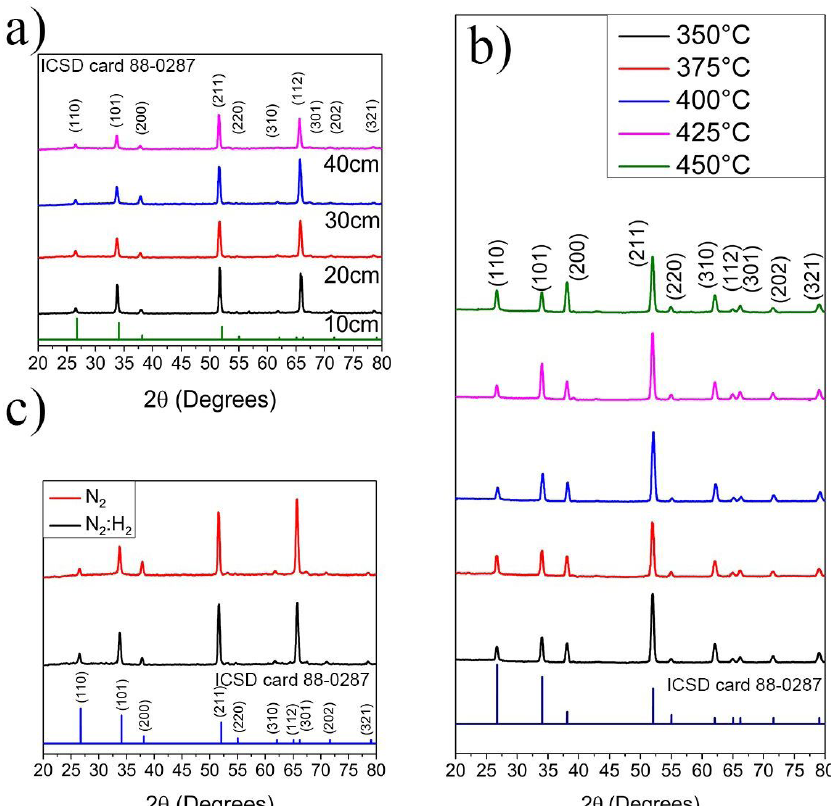
Figure 1. XRD patterns of antimony tin oxide thin films grown by spray pyrolysis at different experimental conditions a) source-substrate distance, b) temperature and c)